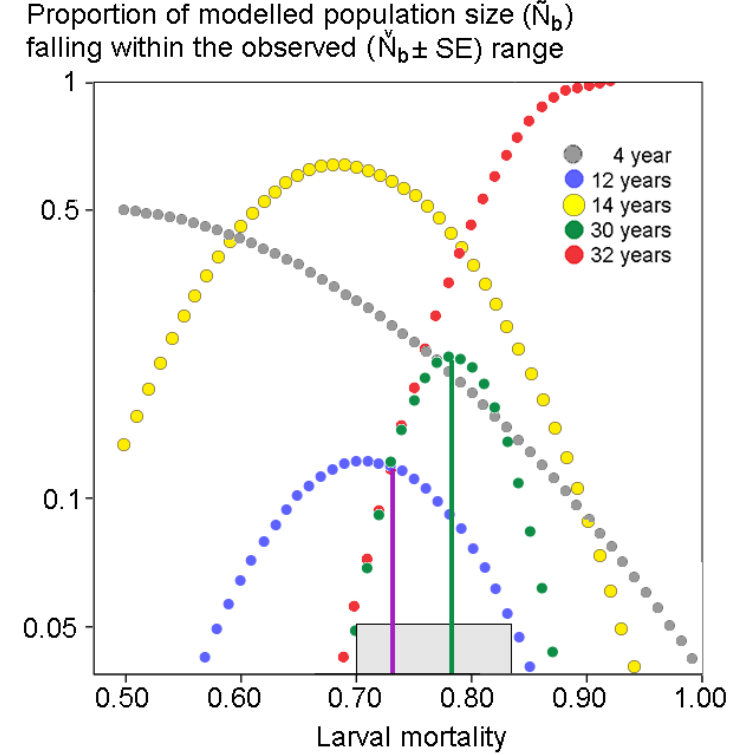
Figure 5. The probability of modeled population sizes of Chioglossa lusitanica at Ribeira de Silveirinhos falling within the population size range estimated in the field ( Ň ± SE), as a function of larval mortality ( q l , horizontal axis). Populations were modeled with Vortex for 4–32 years following the widespread planting of gum trees in 1980. The results were fitted to a Gaussian distribution with Prism 6 software [33] ( r 2 > 0.95) and then log-transformed. Support is maximal for q l = 0.73 (purple bar, p > 0.10). The grey rectangle indicates the 0.70 < q l < 0.83 range over which none of the Ñ - Ň combinations are implausible ( p > 0.05). The green bar highlights the q l = 0.78 value already retrieved for 2010 in Figure 4. Adult mortality q b is set at 0.22; for results with q b = 0.28 see Appendix